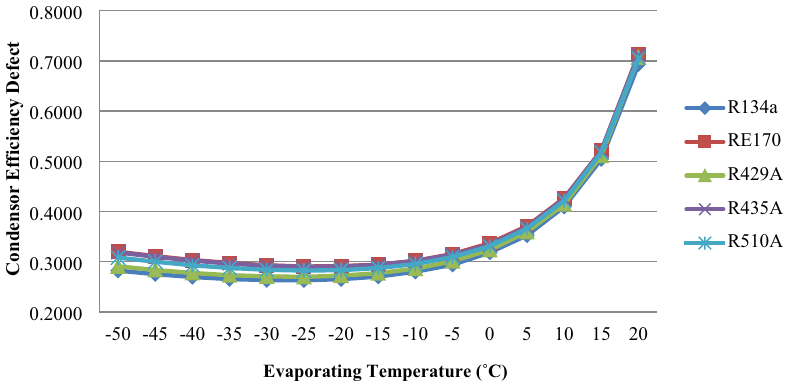
Figure 6. Condensor efficiency defect as a function of evaporator temperature.